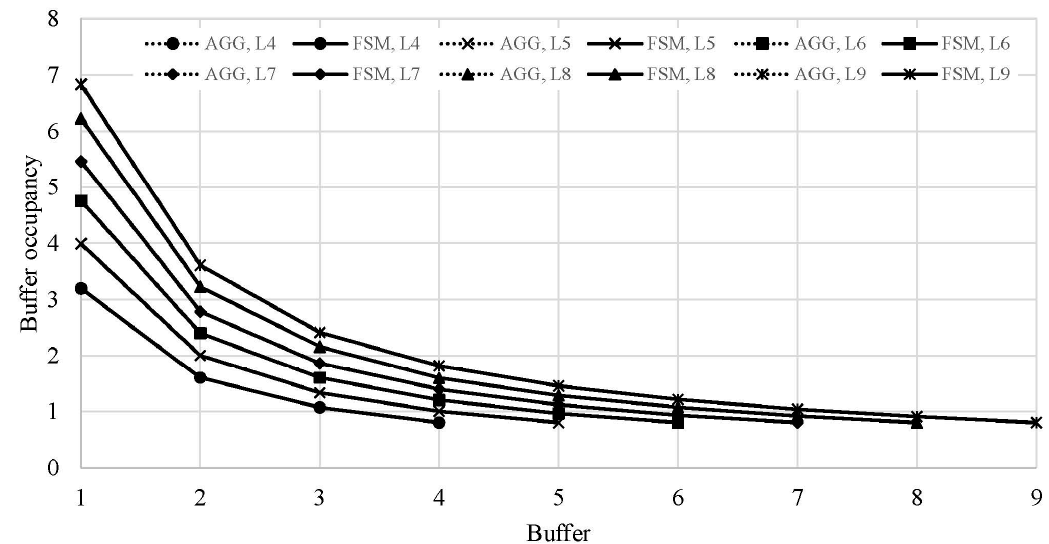
Figure 12. Asymptotic occupancies of buffers, lines L 4 –L 9 (authors’ work).